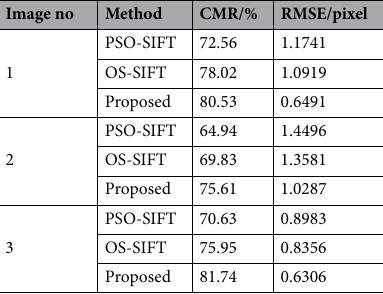
Table 2. Quantitative comparison of the proposed method with other SIFT-based